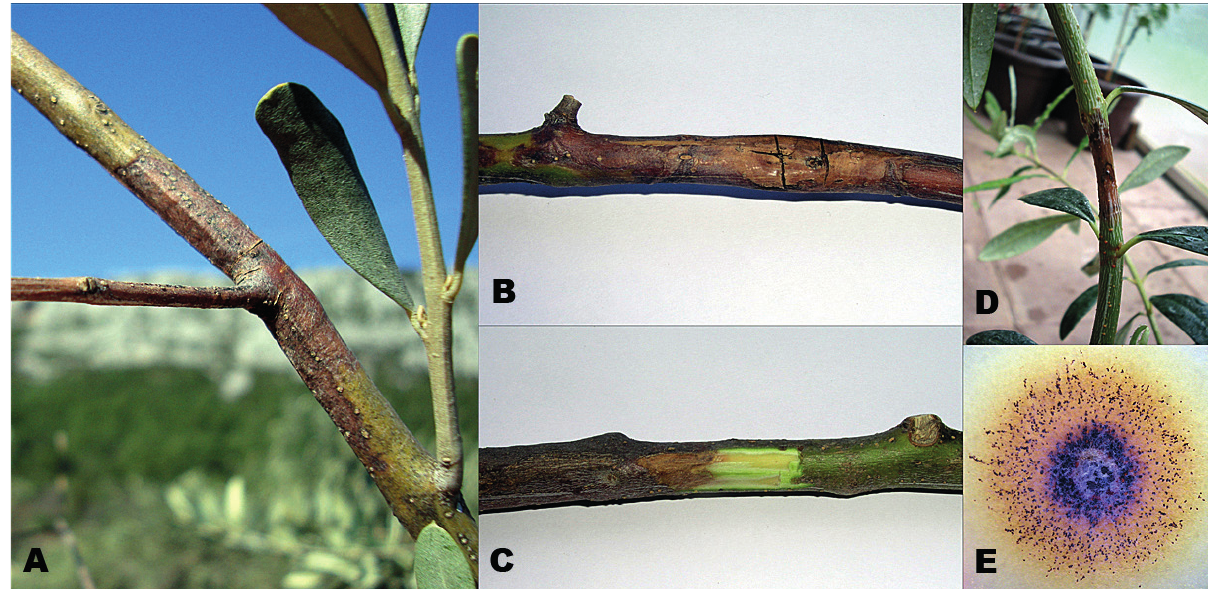
Figure. 1. (A) Lesions on olive shoots; (B) cracks on symptomatic tissue; (C) dividing line between healty and necrotic inner tissue; (D) symptoms on inoculated olive shoot; (E) an isolate of Phoma incompta on